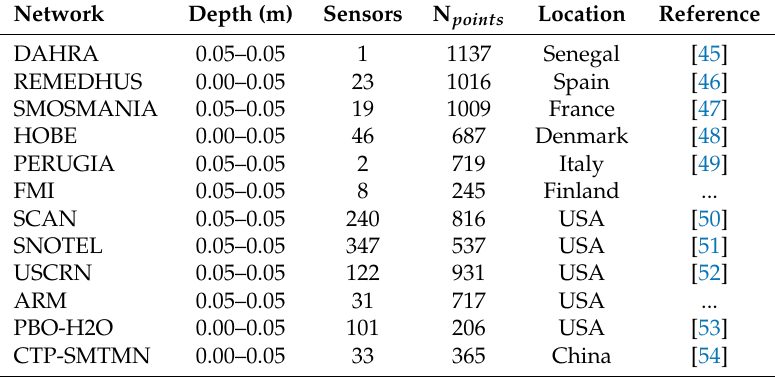
Table 1. In situ networks used in this study. The depths are quoted as two numbers: the first one is the upper depth, and the second one is the lower depth of the sensor. Both numbers are equal when the sensor is placed horizontally. The third column gives the number of sensors remaining for each network after applying all of the criteria used for the evaluation that are discussed in Section 2.4. The fourth column gives the average number of points in the time series for each network that satisfies the evaluation